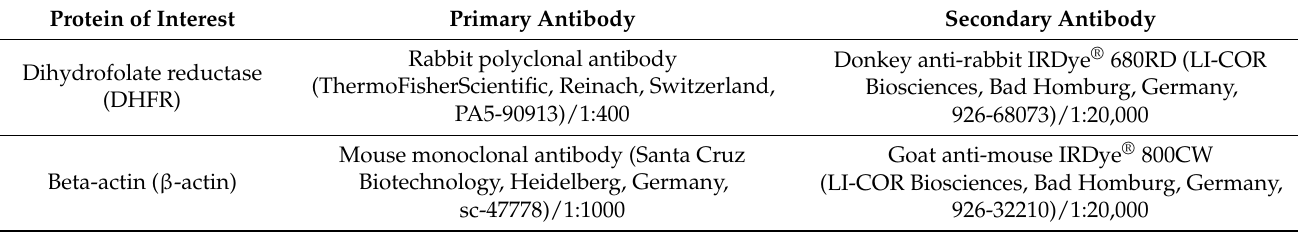
Table 3. Antibodies for Western